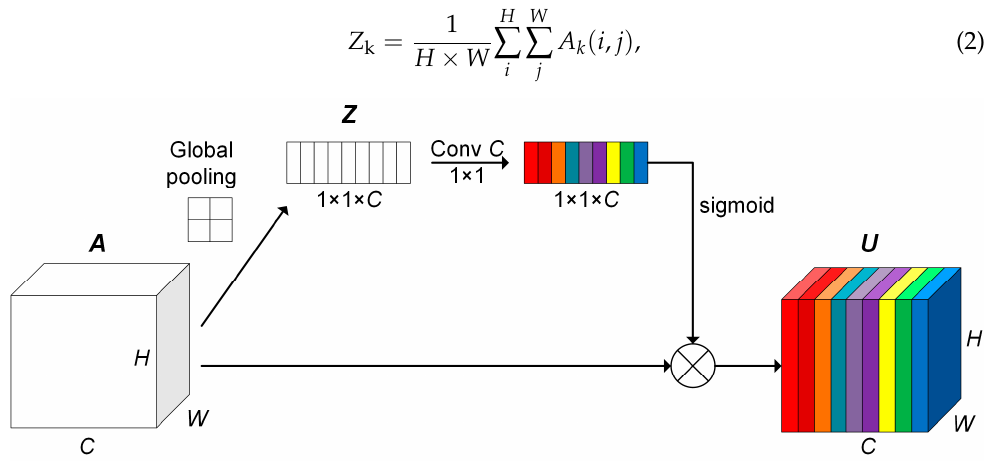
Figure 5. Attention Complementary